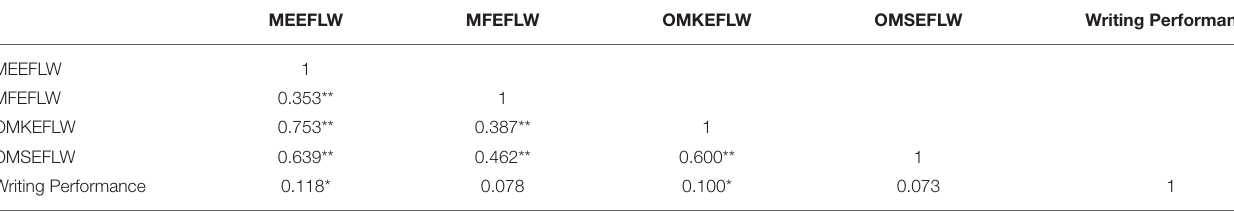
TABLE 4 | Correlation matrix for the four-factor model and writing performance. MEEFLW MFEFLW OMKEFLW OMSEFLW Writing